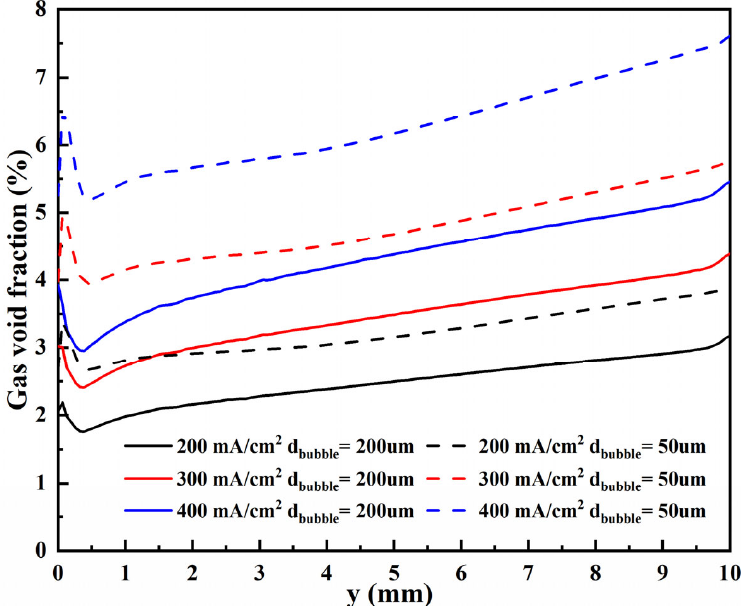
Figure 6. Gas void fraction curves of these two bubble diameters on vertical flat electrodes under different current densities.